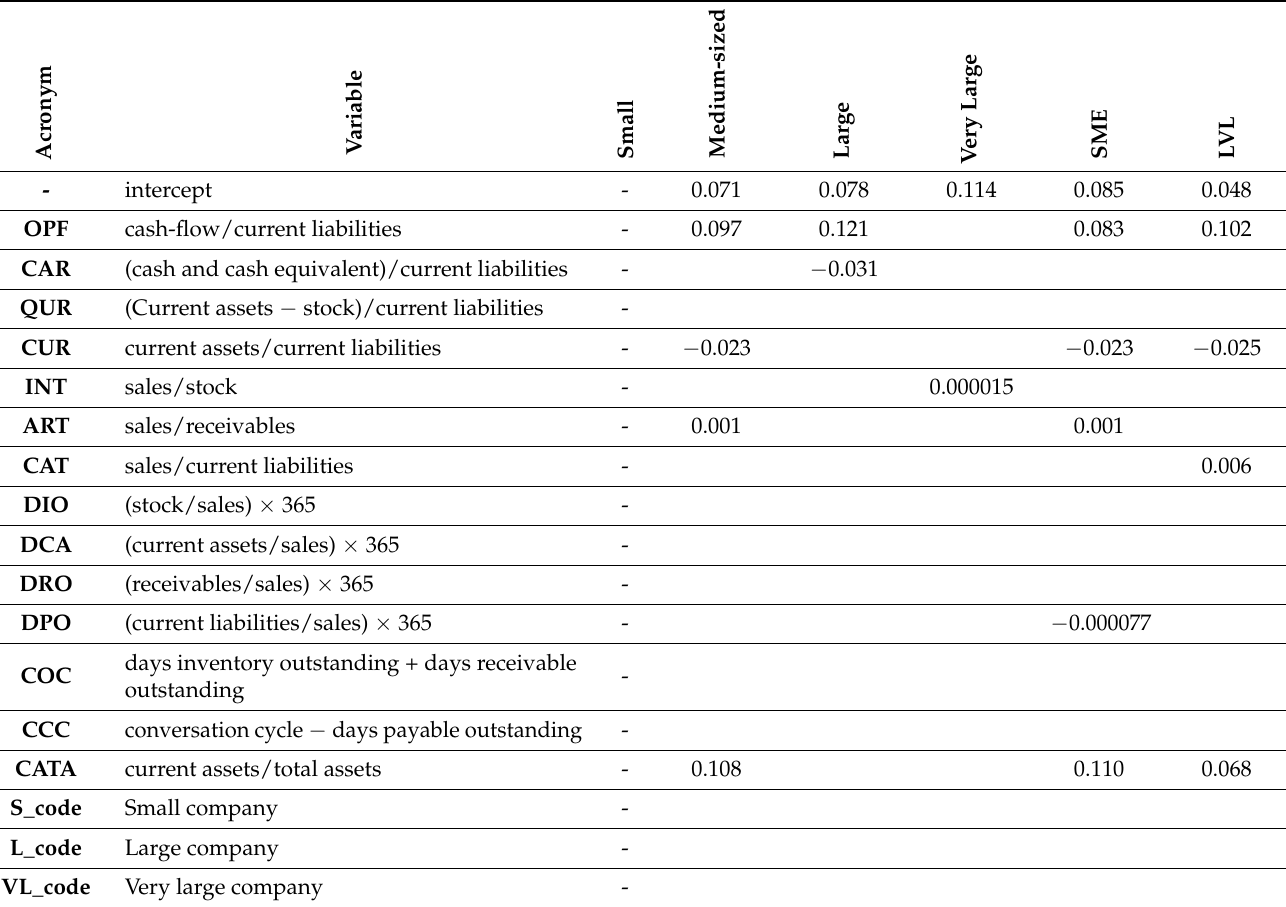
Table 11. Coefficients in models for the transport companies in the Czech